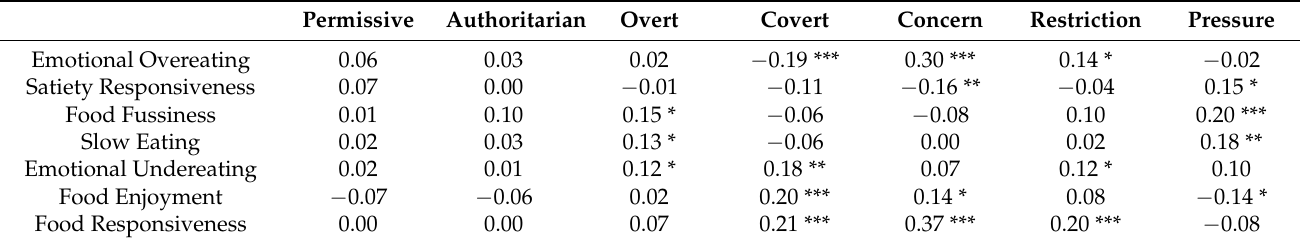
Table 1. Pearson correlations between parental style, child feeding practices and child eating behaviors.